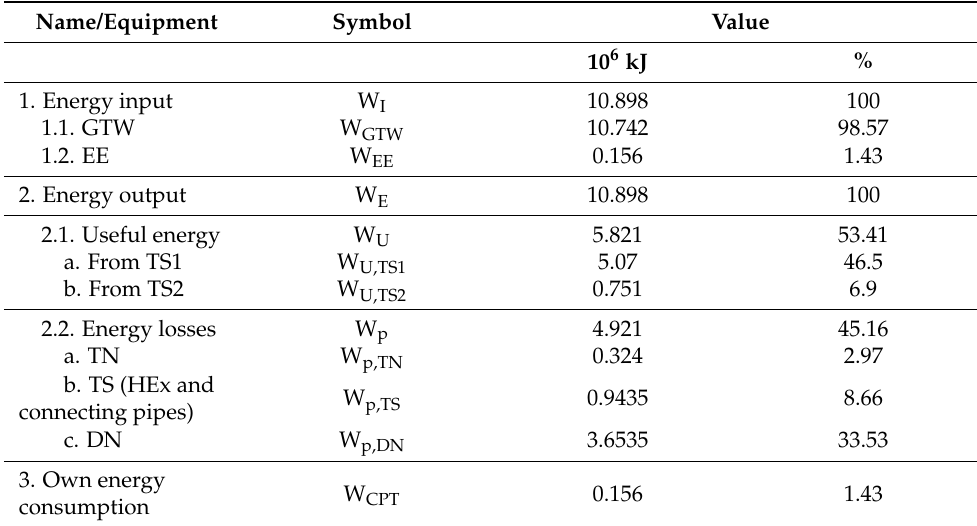
Table 11. HSGWPE real hourly energy balance, period 20–22 January